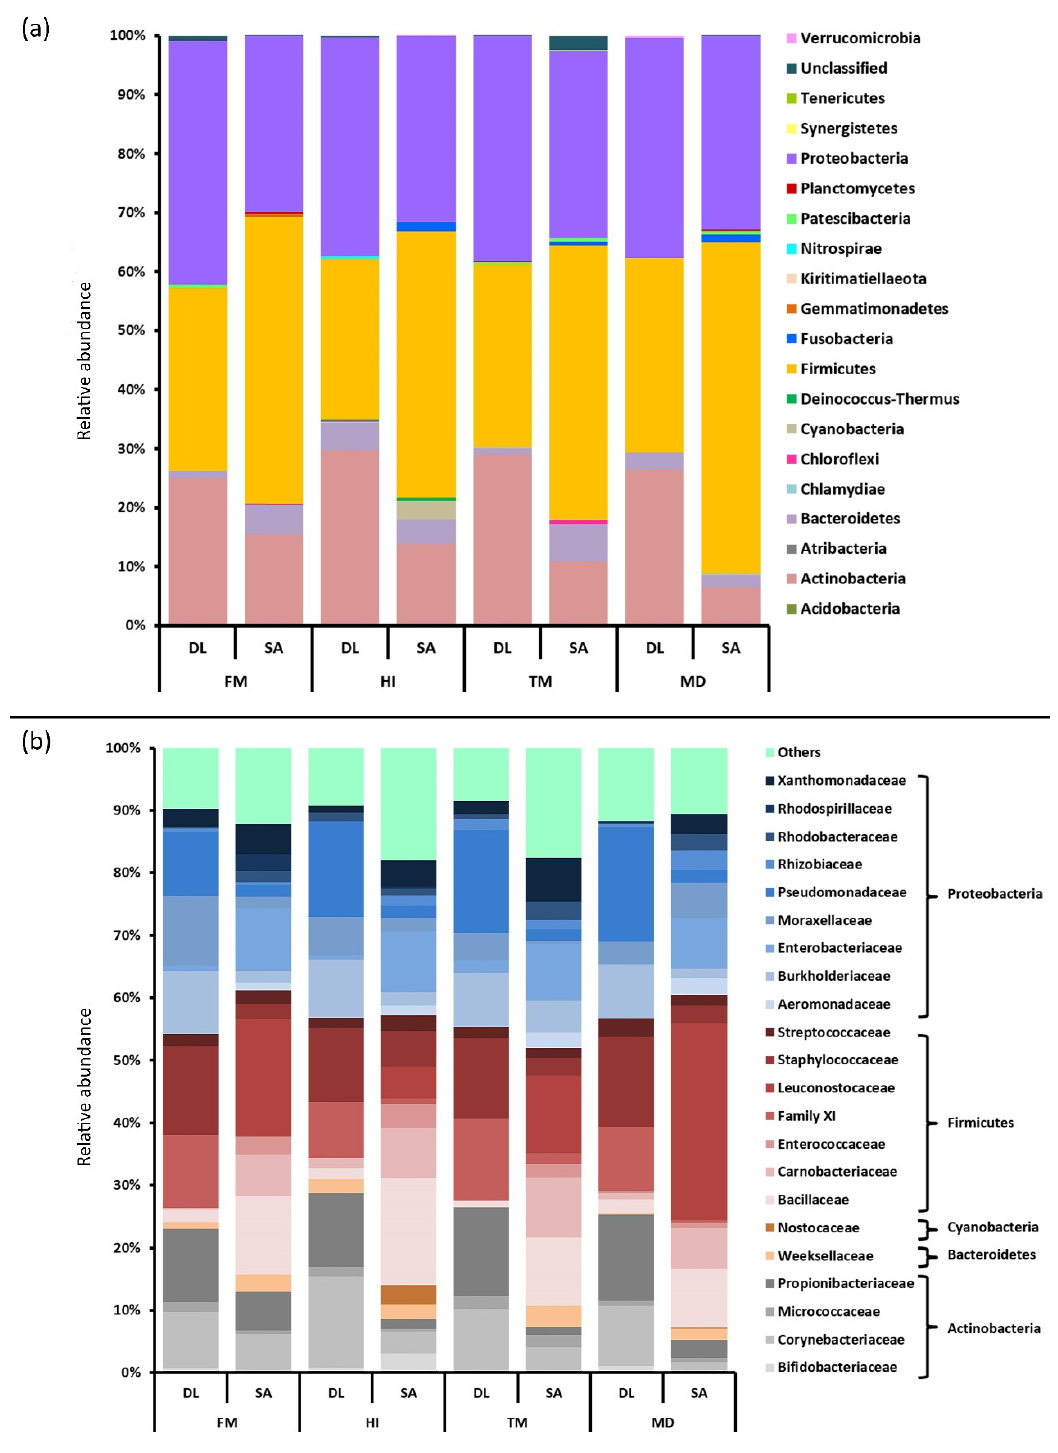
Figure 4. Taxonomic composition of the gut microbial community across the four dietary treatments in Dicentrarchus labrax and Sparus aurata . Stacked bar chart representing the relative abundance of the different bacterial ( a ) phyla and ( b ) families in the gut of D. labrax and S. aurata fed control (FM) and insect diets (HI, TM, MD). Each bar displays the microbial community of 12 individuals fed a specific diet. Bacterial operational taxonomic units (OTU) that could not be classified at phylum level were grouped as ‘unclassified’. Bar charts demonstrate bacterial families with an overall abundance of > 1%. Color legends represent different phylogenetic groups. Abbreviations according to Figure 1.